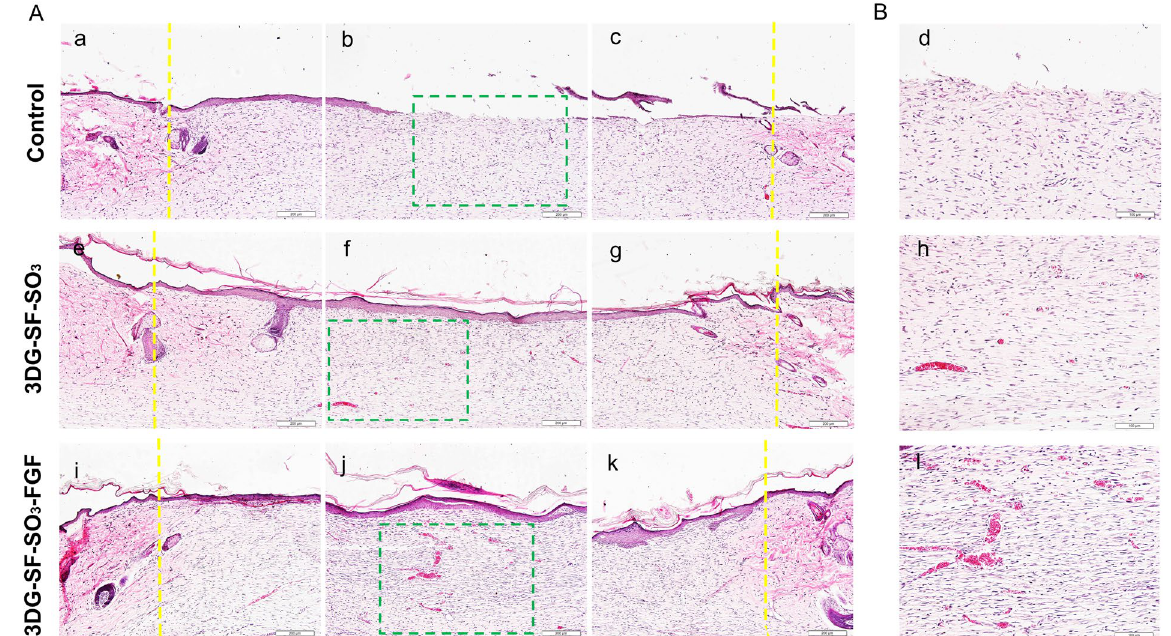
Figure 6. Representative H&E staining of skin tissue sections at day 28 post-surgery. Which illustrate the healing process at the left (a,e,i), centre (b,f,j), and right of the wound (c,g,k). Yellow lines in the images indicated the boundaries between the wound and the surrounding normal skin. ( B ) Magnified view (d,h,l) of the regions in green pane in figure ( A ) (b, f and j). Scale bars = 200 μ m ( A ), and 100 μ m ( B )